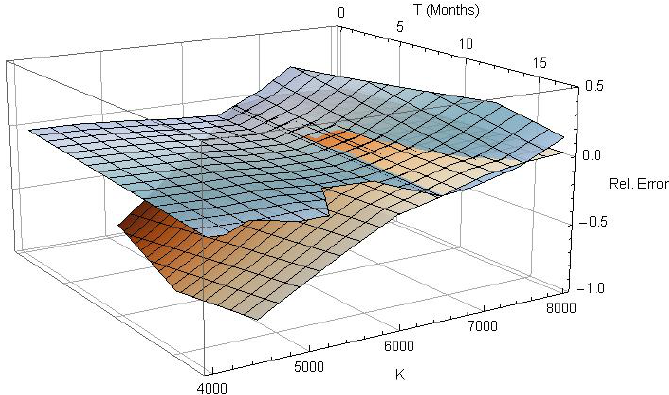
Figure 1. Relative pricing error of European plain vanilla calls (blue) and puts (red) under Black–Scholes . The interpolated call (blue) and put (red) surfaces in Figure 1 indicate that the relative error under Black–Scholes is moderate for in-the-money contracts, but grows formidable for out-of-the-money contracts. By using the right pricing density, both surfaces should be flattened out in time-to-maturity, as well as in moneyness